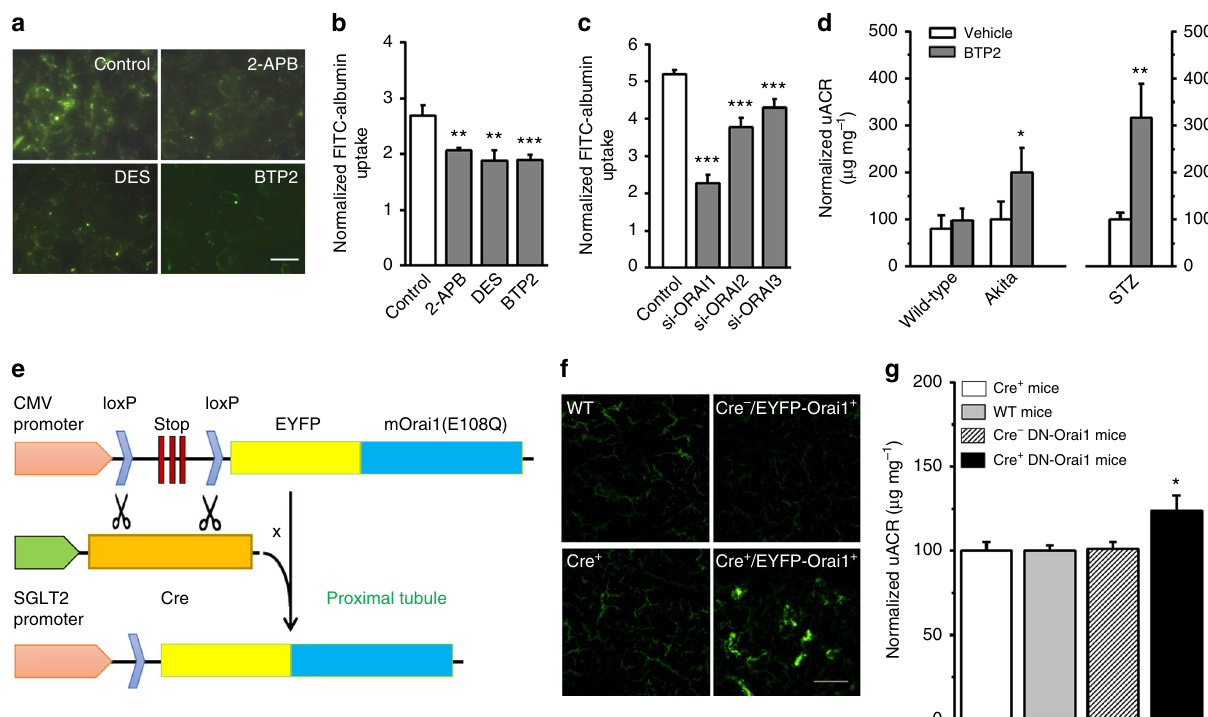
Fig. 3 ORAI channels determine albumin reabsorption in vitro and in vivo. a FITC-albumin uptake by human proximal tubular epithelial HK-2 cells after incubation with FITC-albumin (50 µ g mL − 1 ) for 60 min with or without 2-APB (100 µ M) or DES (10 µ M) or BTP2 (1 µ M). Scale bar, 25 µ m. b Mean ± s.e.m. data for the fl uorescence of FITC-albumin uptake by PTECs in a . The fl uorescence was normalized by the total lysed protein ( n = 6 for each group). c HK-2 cells were transfected with ORAI siRNAs (si-ORAI1/2/3) and scramble siRNA (control) ( n = 7 each group). d Male Akita type 1 diabetic mice (C57BL/6- Ins2Akita/J) and STZ-induced diabetic male C57BL/6 J mice were injected either with BTP2 (0.29 mg kg − 1 , i.p., b.i.d) for 3 days, or vehicle (saline) as control ( n = 9 – 10 for each group). Age-matched non-diabetic wide-type male mice were also used ( n = 13 – 14). Urine albumin-creatinine ratio (uACR) was measured on day 5. e Schematic representation of Cre-LoxP-mediated recombination and generation of a linear product contain one lox-P site and the target gene (EYFP-mOrai1 E108Q mutant) via crossing the Cre + mice with proximal tubule-speci fi c expression driven by sodium-glucose cotransporter 2 (SGLT2) promoter. f Expression of EYFP-mOrai1 E108Q mutant in tubules (Scale bar, 200 µ m). g Urine albumin-creatinine ratio (uACR) was measured in male DN-Orai1 transgenic mice and littermates on day 32 – 38 after birth ( n = 27, 34, 17 and 17 for Cre + , wild-type, Cre − -DN-Orai1 and Cre + -DN-Orai1 mice, respectively). Average data are presented as mean ± s.e.m. Data sets are compared by t test in ( d ) and by ANOVA in ( b , c , and g ). Statistical signi fi cance